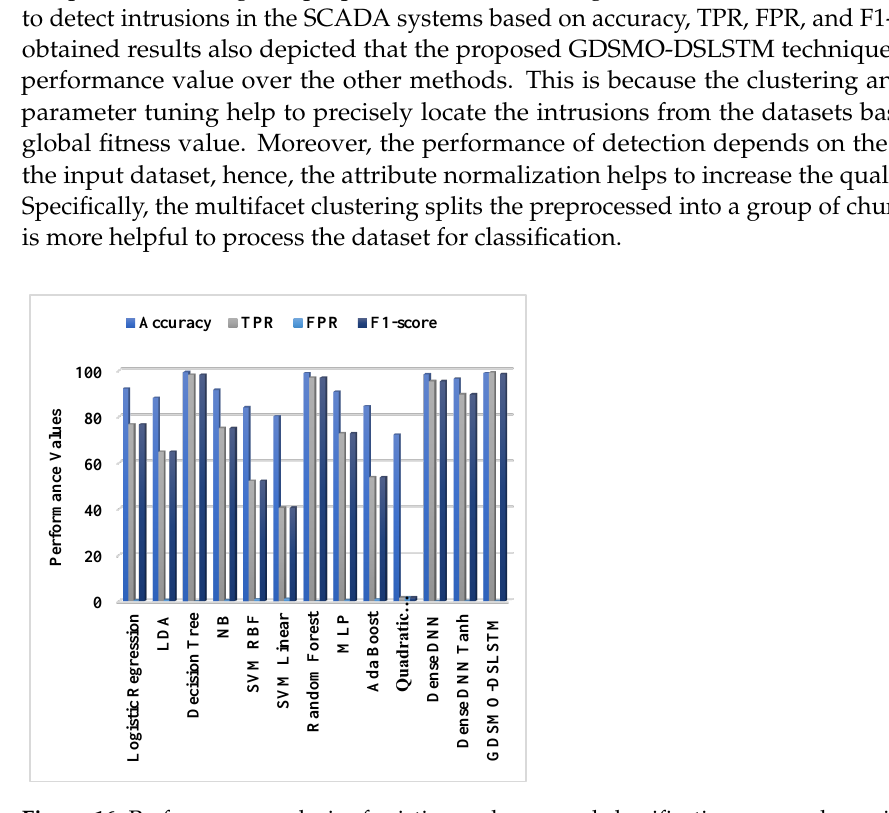
Figure 16. Performance analysis of existing and proposed classification approaches using the CSE-CIC-IDS 2018 dataset. Table 4. Analysis based on accuracy, TPR, FPR, and F1-score.